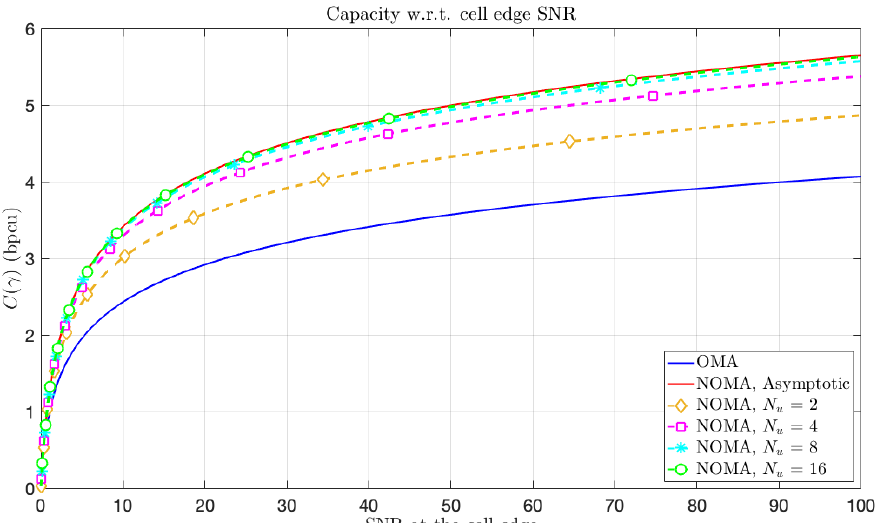
Figure 5. NOMA Cell capacity C ( γ ) under symmetric-information for a given SNR γ at cell edge (red), achievable symmetric-rate with OMA (blue) and capacity under FTT constraint with N u layers for N u ∈ { 2,4,8,16 }